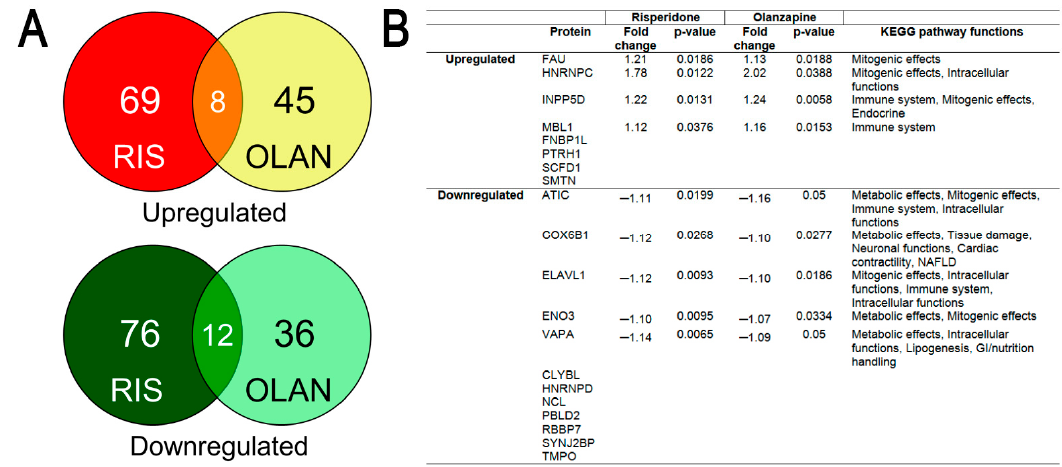
Figure 2. Proteomic analysis of hepatic proteins di ff erentially expressed (DE) by both risperidone and olanzapine. ( A ) Venn diagrams showing shared proteins that are significantly upregulated (top) or downregulated (bottom) in risperidone (RIS)- or olanzapine (OLAN)-treated mice ( p < 0.05). ( B ) Of the 20 shared proteins, 9 were found to have KEGG (Kyoto Encyclopedia of Genes and Genomes) pathway maps from which predicted functional changes could be determined. Statistical significance ( p < 0.5) of di ff erentially expressed (DE) proteins relative to vehicle (VEH). RIS n = 5; OLAN n = 4; VEH n = 4. Abbreviations: NAFLD, non-alcoholic fatty liver disease; GI,